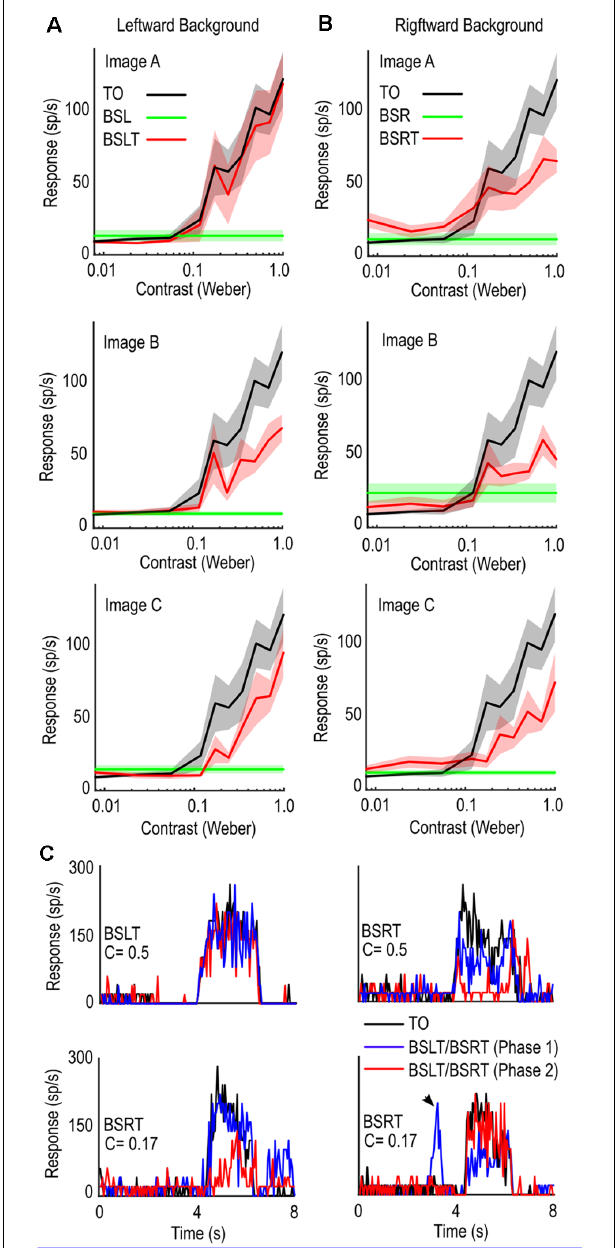
FIGURE 4 | Contrast sensitivity functions in the presence of background clutter. (A) Comparison of target alone (black line) and target with background trial (red line) for targets of varying contrasts for leftward moving backgrounds. Introduction of background clutter causes a reduction in mean spike rate. (B) as (A) for rightward moving backgrounds. (C) Individual trials from three cells showing spike rate over time (Peristimulus Time Histogram). TO controls (Black) are more consistent than BSLT and BSRT trials with shifted phases (Blue, Red). Sporadic excitation can occur when target is in CSTMDs inhibitory hemifield indicating responses to background features (bottom right, black